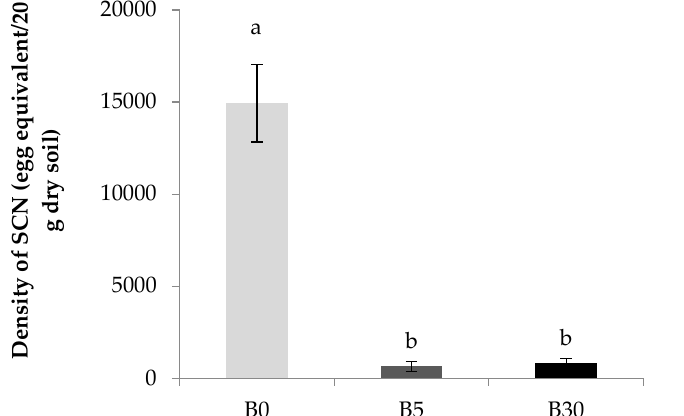
Figure 4. Density of soybean cyst nematode (SCN) (egg equivalent based on the Ct value in real-time PCR assay 1 in the lower layer soil under biochar amended 0.3% (B5), 1.8% (B30) and not-amended upper layer (B0) after 16 weeks of mung bean residue incorporation. Bar indicates average and standard error (n = 3). Different letters present the significant differences among treatments from Tukey HSD test at p < 0.05 by one-way ANOVA. 1 Calibration equation: y = − 2.82x + 34.5, R 2 = 0.9782; y: Ct value; x: log 10 SCN 20 g −1 ) [40].